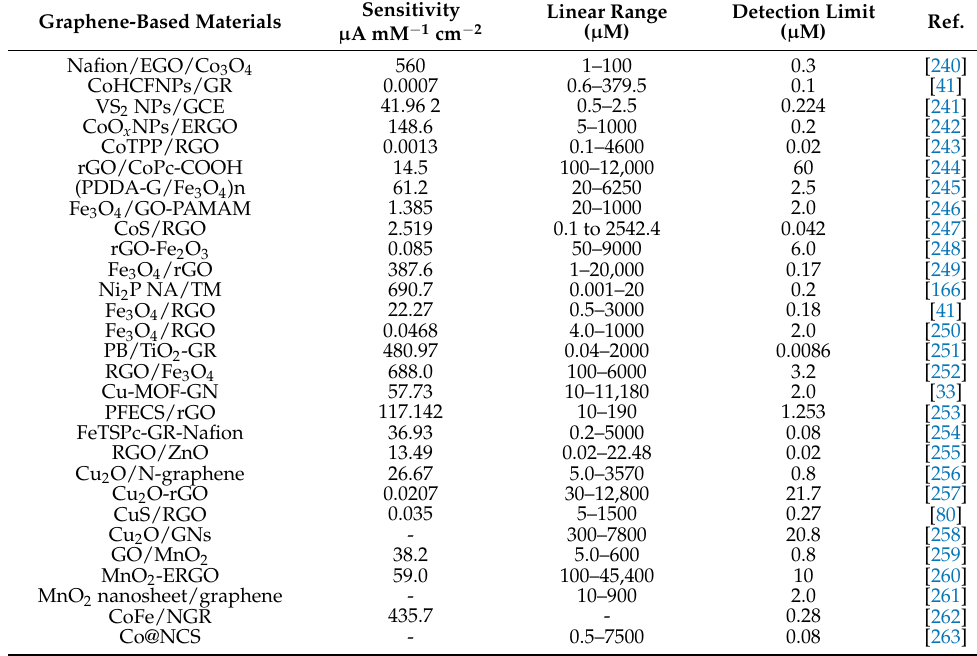
Table 3. Graphene-supported non-Noble metal nanoparticles for electrochemical detection of H 2 O 2 . Graphene-Based